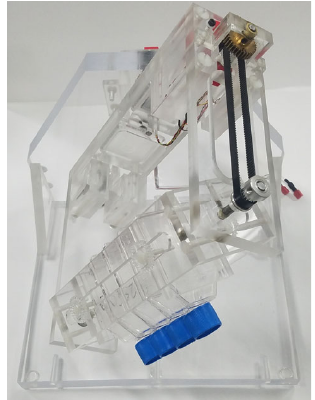
Figure 8. Three-dimensional clinostat used to simulate